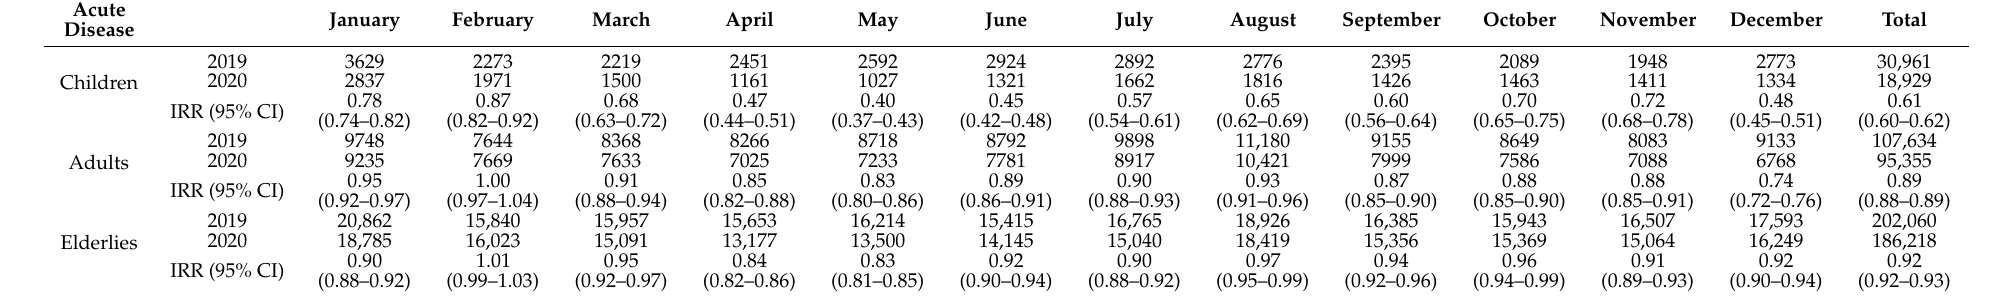
Table 5. The number of emergency patients for acute disease registered in the Osaka Emergency Information Research Intelligent Operation Network system. Acute Disease